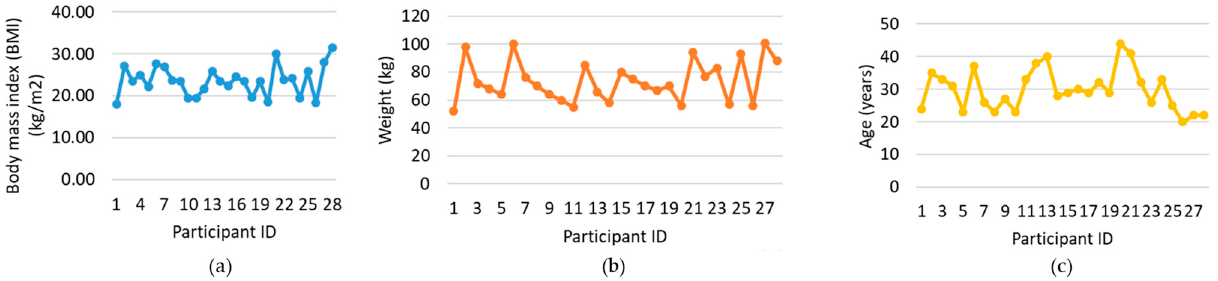
Figure 9. Participants’ body mass index (BMI) ( a ), weight ( b ), and age ( c ).